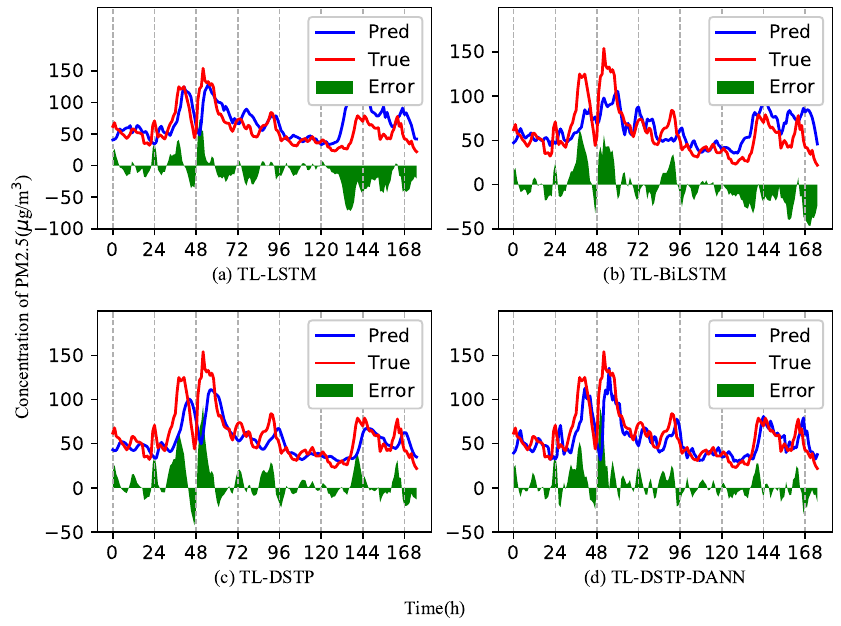
Figure 6. Prediction of real and predicted PM2.5 concentrations at Guangzhou station using differ- ent